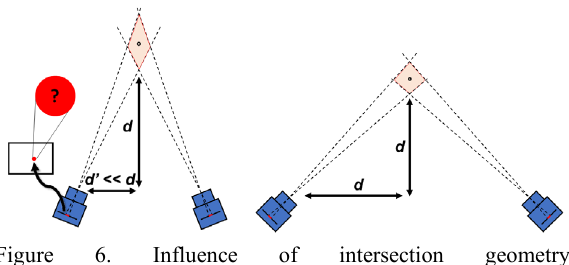
Figure 6. Influence of intersection geometry. Adapted from (Luhman et al., 2011).